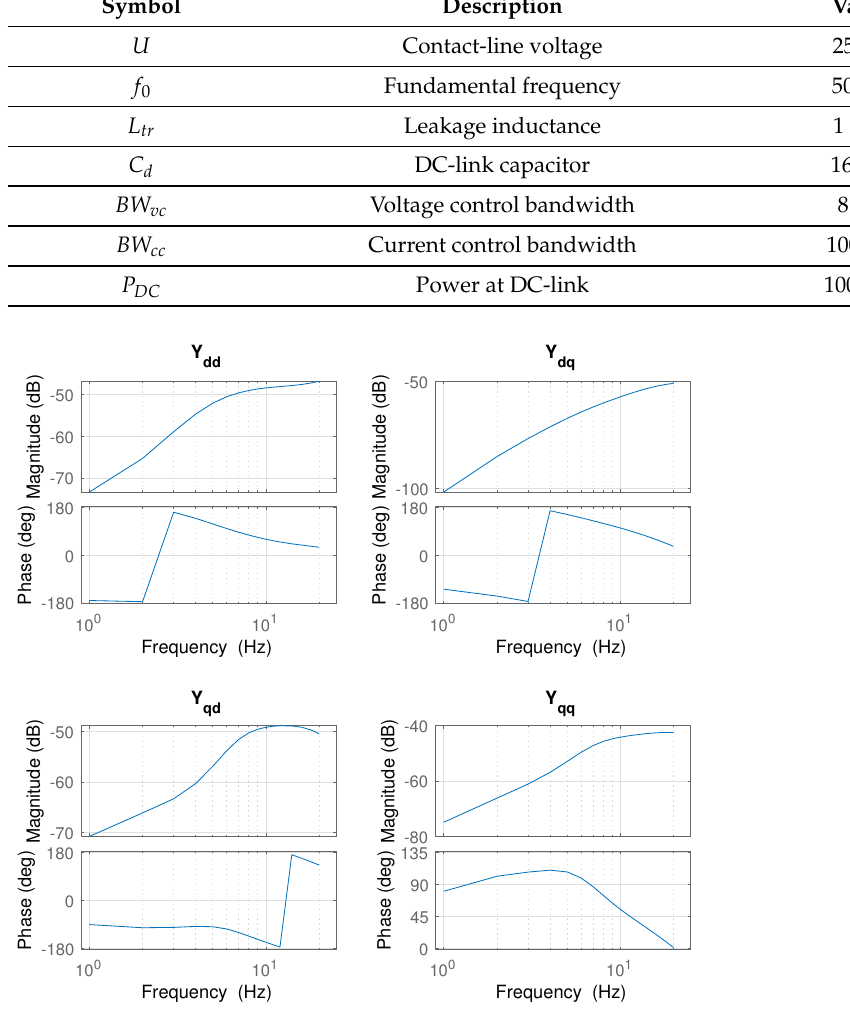
Figure 4. Traction-chain input admittance. Frequency range: 1–20